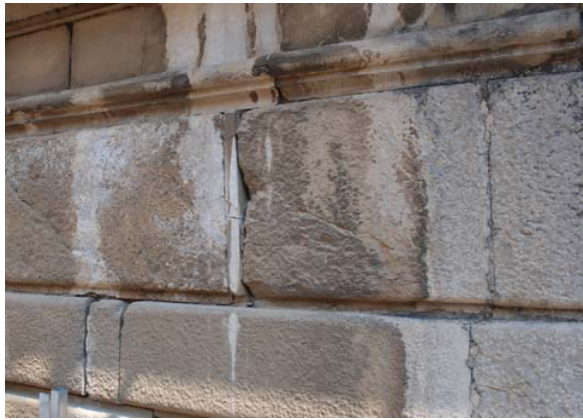
Figure 8. Stones on Façade of Royal Palace in Caserta